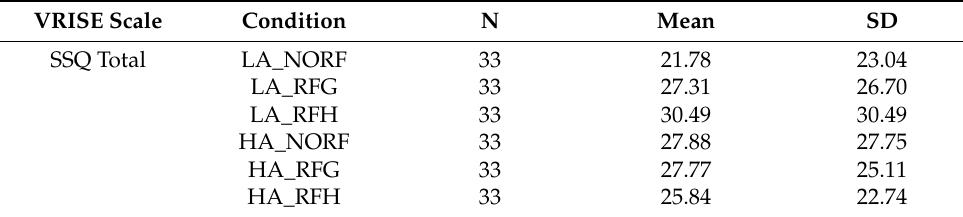
Table 3. Subjective VRISE levels assessed by SSQ, FMS, and VRNQ (VRISE Section) questionnaire. The results are presented by game conditions. VRISE